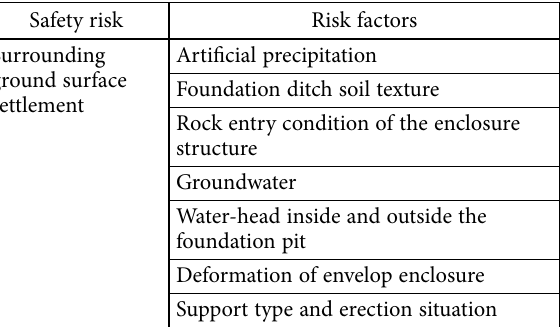
Table 2. List of risk factors obtained from the Compilation of